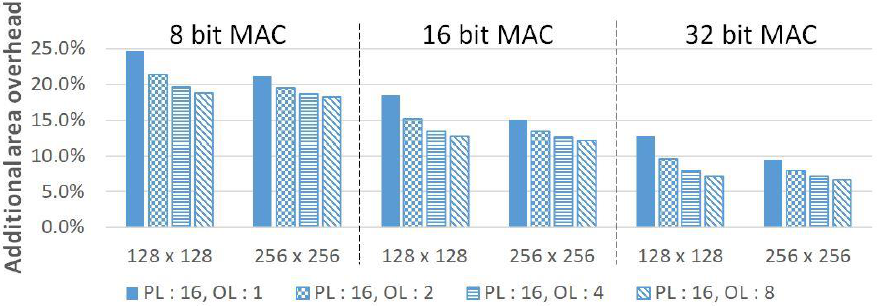
Figure 11. Hardware overhead comparison for various OL s.